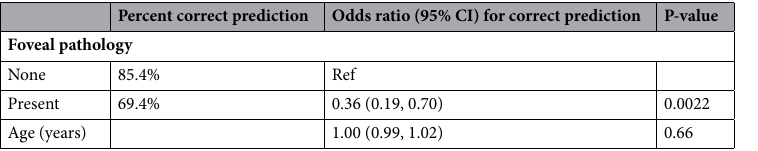
Table 2. Model performance on external validation dataset subgrouped by presence of foveal pathology.